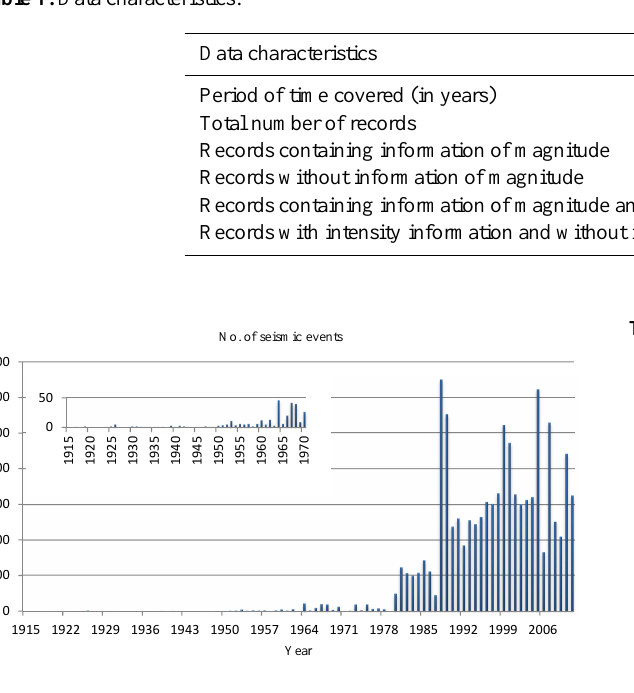
Fig. 3. Annual seismicity. Figure 3. Annual Seismicity. 3